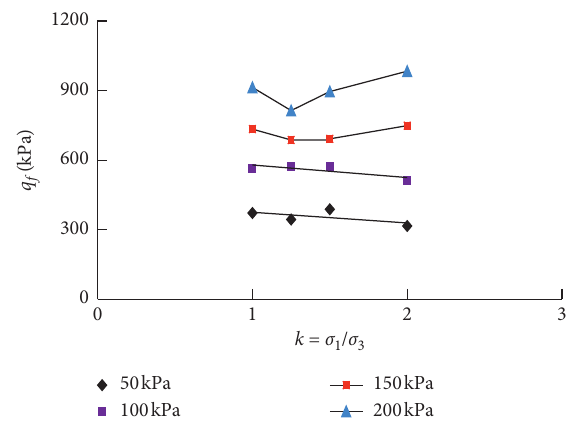
Figure 17: Change law between q